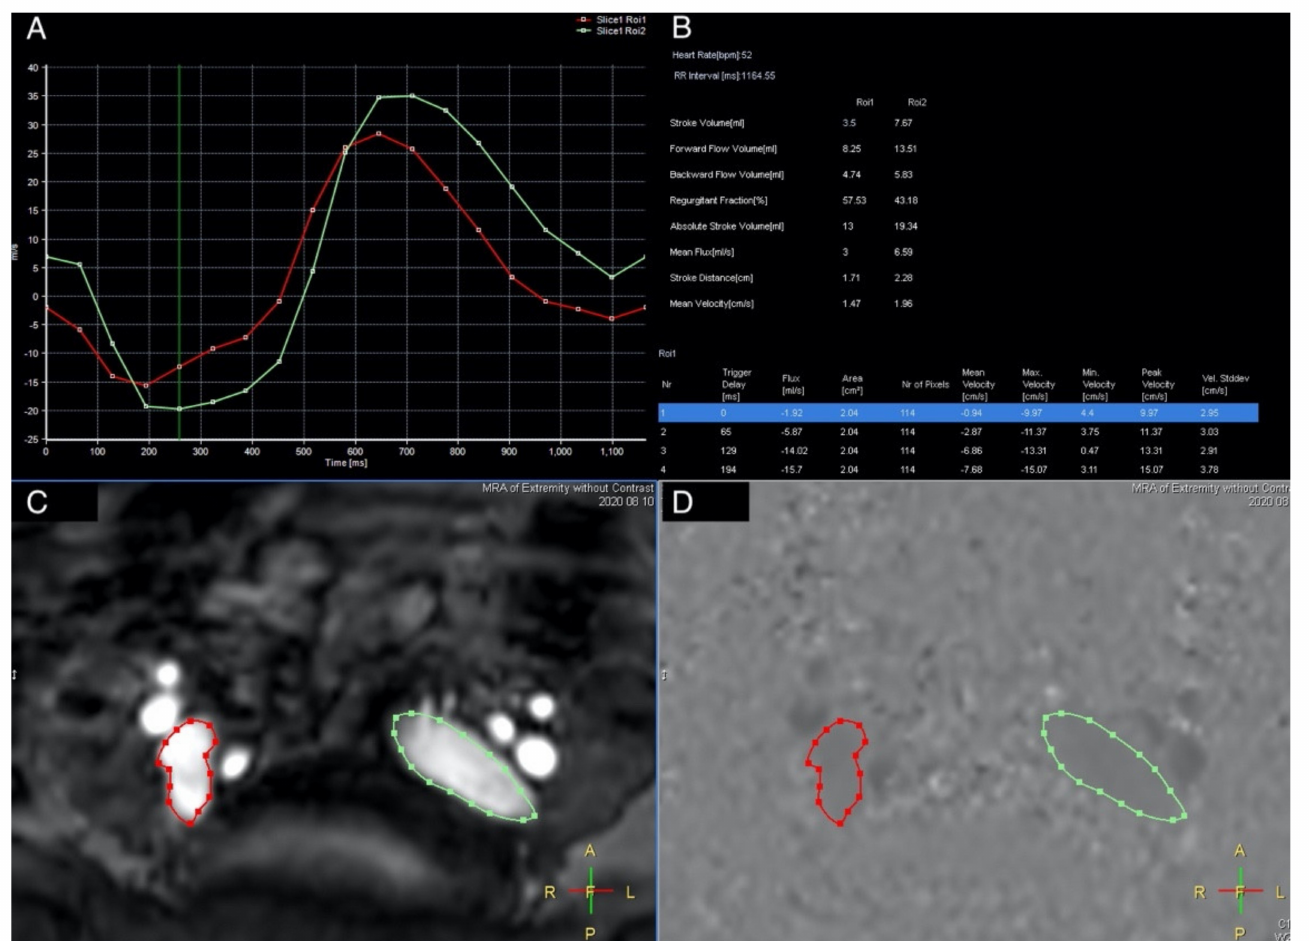
Figure 3. QFlow scan in a TRANCE MRI consisting of the stroke volume, forward flow volume, backward flow volume, regurgitant fraction, absolute volume, mean flux, stroke distance, and mean velocity. ( A ) Two external iliac veins with the flow sequence by time. ( B ) QFlow parameters with different trigger delays. ( C ) Regions of interest of both the external iliac veins. ( D ) Image during data acquisition. (green circle: left external iliac vein, red circle: right external iliac